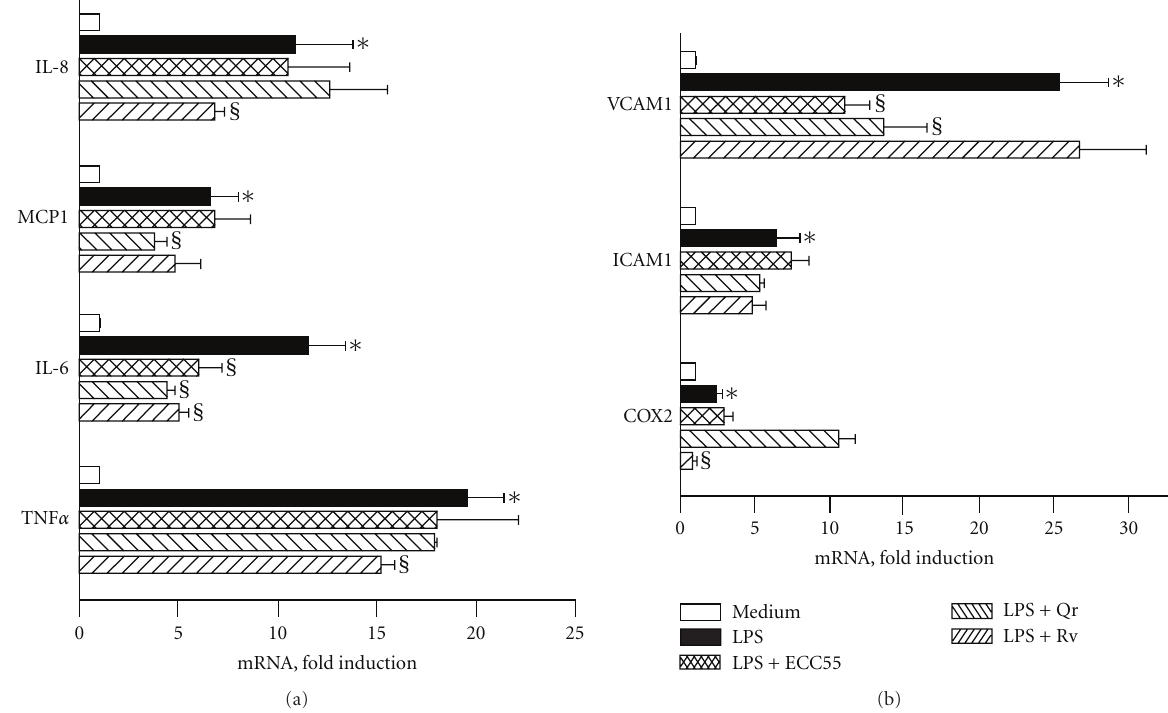
Figure 5: E ff ects of concentrated ethanol extract of Edelweiss callus cultures (ECC55) and reference anti-inflammatory plant polyphenols on inflammatory gene expression in human vascular endothelial cells (HUVECs) challenged with bacterial lipopolysaccharide (LPS). Abbreviations: Qr = quercetin, 25 μ g/mL; Rv = resveratrol, 25 μ g/mL; IL-8 = interleukin 8; MCP-1 = monocyte chemotactic protein-1; IL-6 = interleukin 6; TNF α = tumor necrosis factor alpha; VCAM1 = vascular cellular adhesion molecule-1; ICAM1 = intercellular adhesion molecule-1; COX2 = cyclooxygenase 2. Error bars in all figures correspond to S.D. ∗ P < 0.01 versus untreated control; § P < 0.01 versus LPS-treated